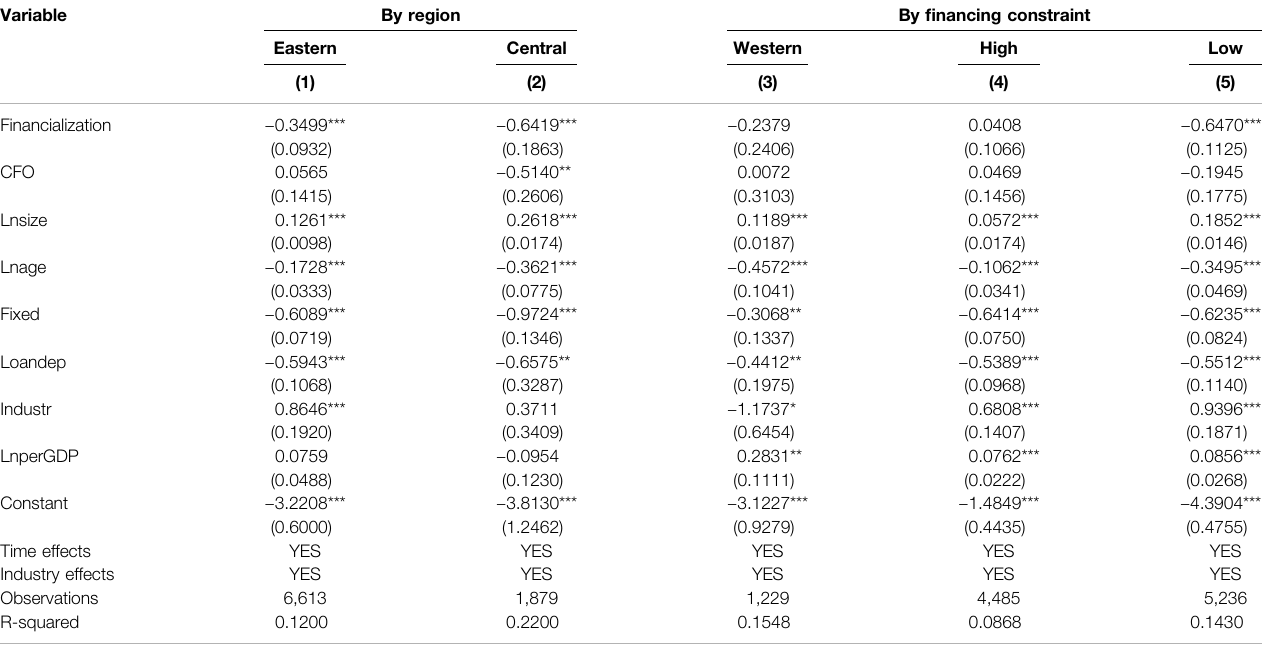
TABLE 6 | Estimation results of the impact of corporate fi nancialization on green technology innovation.